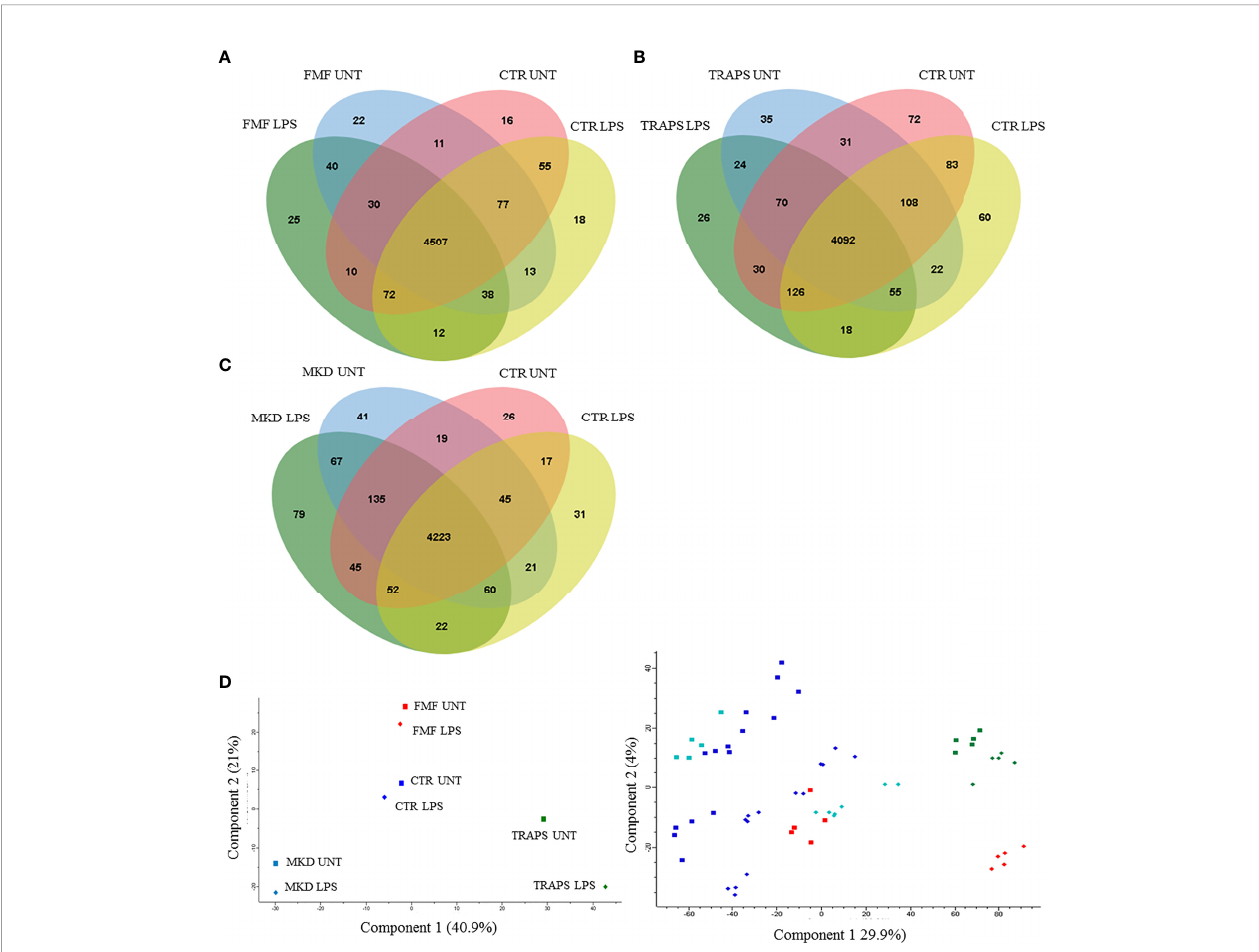
FIGURE 1 | Venn diagram shows the number of proteins in untreated and LPS-treated monocytes of patients with FMF (A) , TRAPS (B) , and MKD (C) compared to HD. Principal component analysis (D) shows discrimination between proteins of untreated (squares) and LPS-treated (rhombus) monocytes of patients with FMF (red), TRAPS (green), MKD (light blue) and HD (blue). The left panel represents the components ’ means distribution of the different samples for each group of HRF and HD; the right panel represents the distribution of the individual samples for each group of HRF and